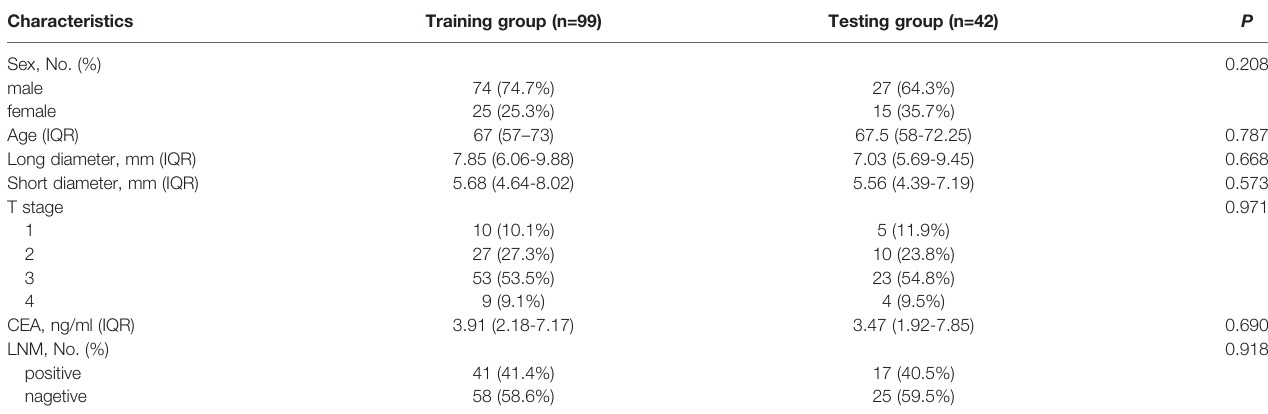
IQR, interquartile range.